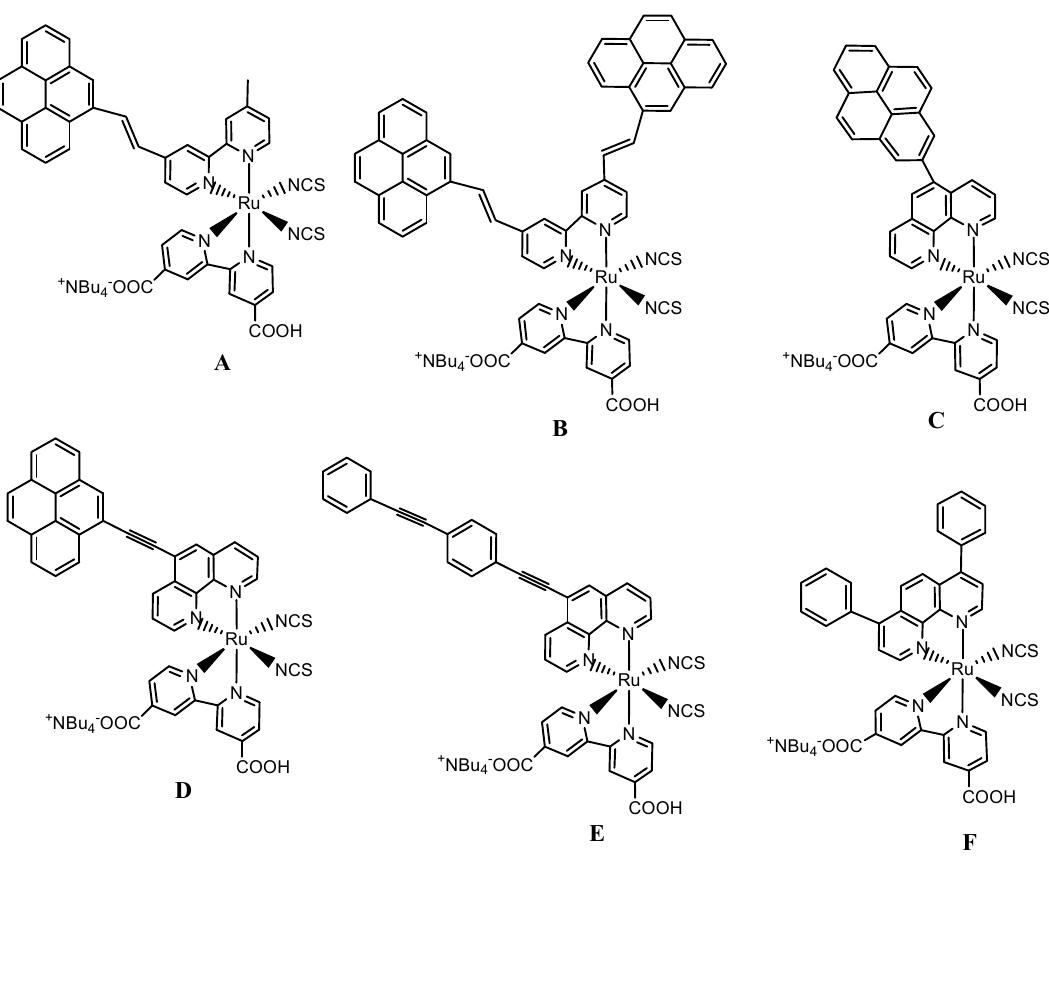
(L) (NCS) ] 2+ analogues n m 2